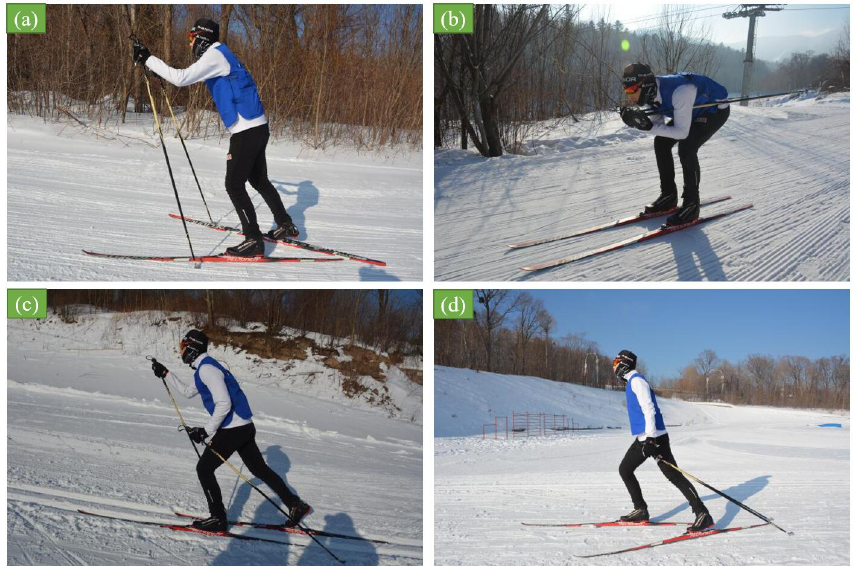
Figure 6. Freestyle cross-country skiing typical sport postures: ( a ) free uphill; ( b ) free downhill; ( c ) two-step one support; ( d ) free flat.